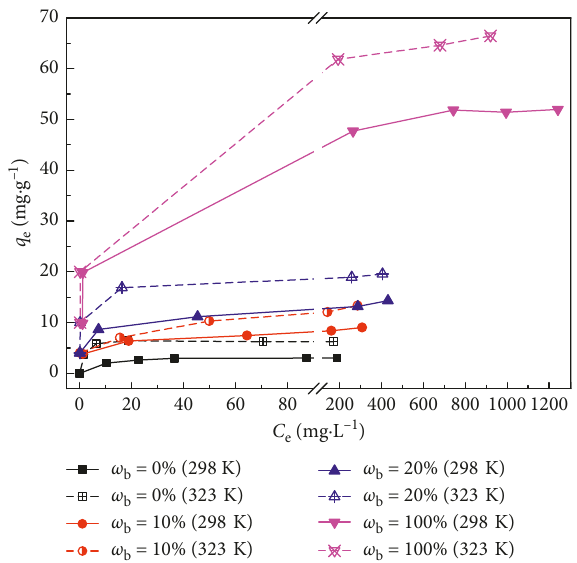
Figure 7: Adsorption isotherm of Pb(II) ( s / w